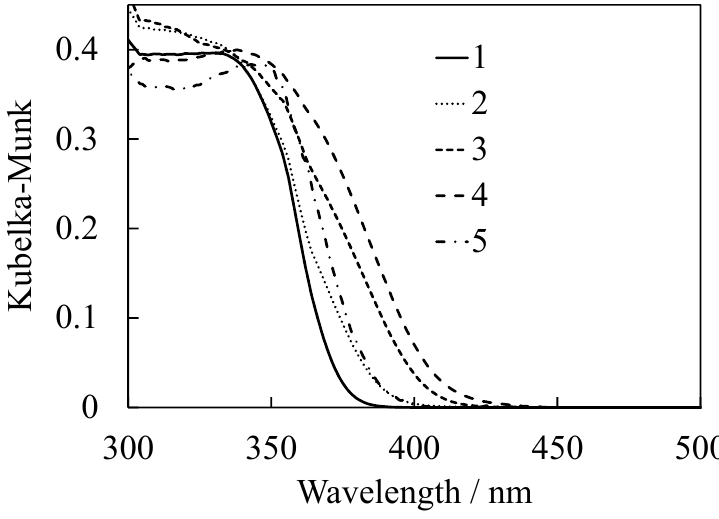
Figure 3. UV-visible diffuse reflectance spectra of (1) Sample T; (2) Sample S0; (3) Sample S300; (4) Sample S400 and (5) Sample S600 expressed by the Kubelka-Munk function approximating the absorbance.